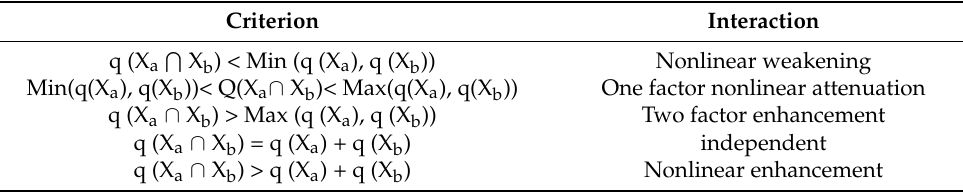
Table 2. Interaction detection by the Geographic detector